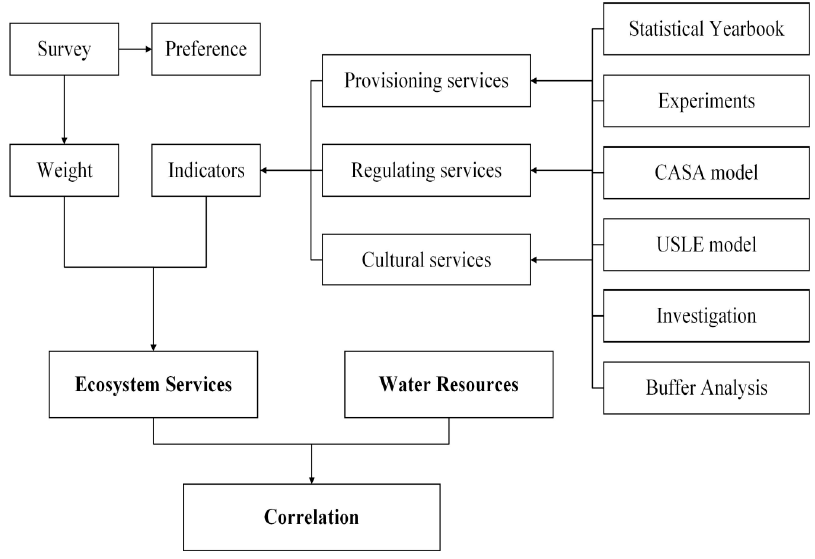
Figure 1. Flowchart. Figure 1.